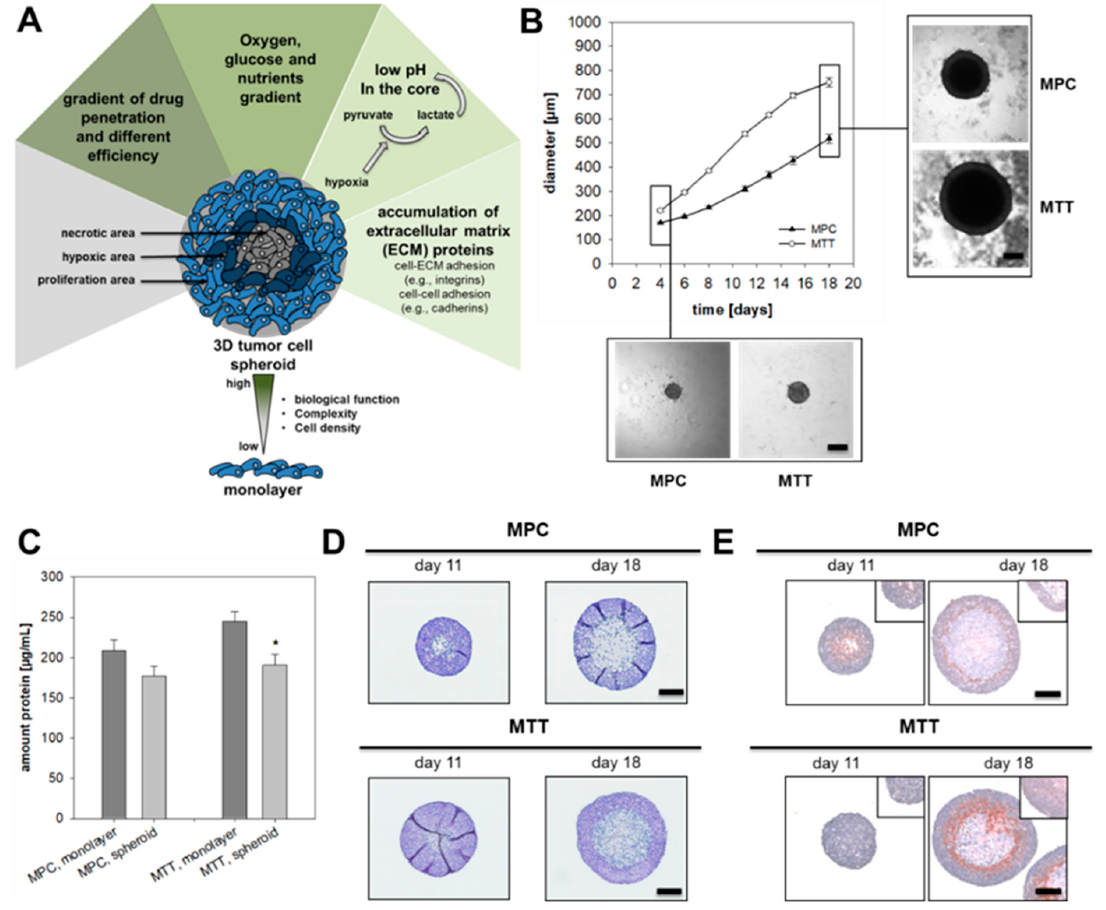
Figure 1. Characterization of pheochromocytoma cell spheroids. ( A ) Tumor cell spheroids are characterized by a necrotic core surrounded by hypoxic cell layers and an external zone of proliferating cells. This structure encourages the formation of an oxygen, pH and nutrient gradient and leads to accumulation of extracellular matrix proteins. Complexity and comparability with the structure of a metastasis offers an important tool for drug screening. ( B ) Growth pattern of MPC and MTT cell spheroids generated by using methylcellulose method. Four independent experiments ( n = 15–20). Mean ± SEM. ( C ) Impact of spheroid cultivation on the amount of protein produced by 500 cells over a time-period of eight days in comparison to monolayer conditions. Four independent experiments ( n = 16). Mean ± SEM. ANOVA and Bonferroni post hoc test comparison vs. monolayer, * p < 0.05. ( D ) Representative section of pheochromocytoma cell spheroids stained with Hematoxylin and Eosin (nuclei: blue, cytosol: violet). ( E ) Covalent binding of pimonidazole confirmed the development of a hypoxic region (red) surrounding the necrotic core of the spheroids (nuclei: blue). Scale bar: 200 µm.